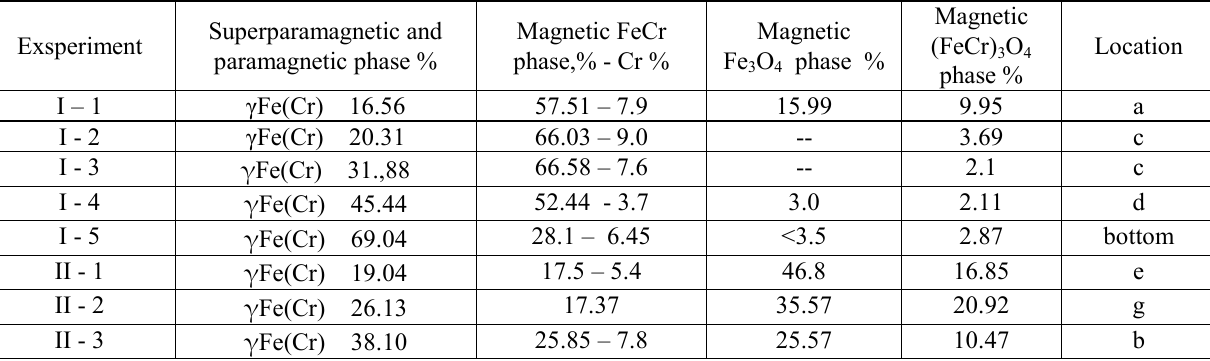
Fig 2. Mössbauer spectra of the samples. a) - erosion products collected from lower edge of the part, b) - erosion products collected at a distance of 500 mm from the cut zone Table 1. Phase composition of the samples